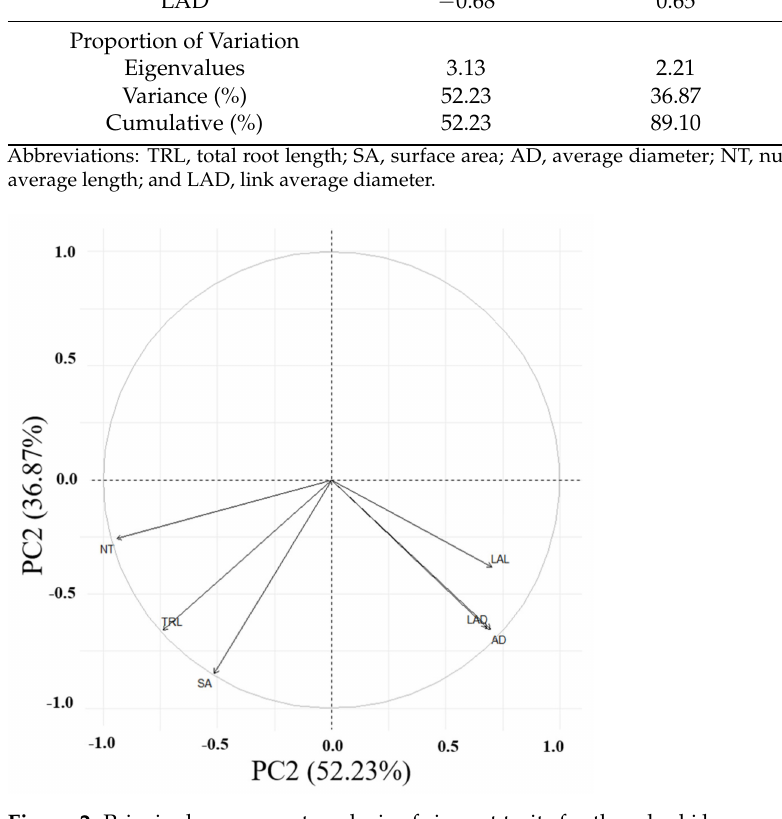
Figure 2. Principal component analysis of six root traits for the adzuki bean accessions. PC1 vs. PC2 represents 89.10% of the total variation. Abbreviations: TRL, total root length; SA, surface area; AD, average diameter; NT, number of tips; LAL, link average length; LAD, link average